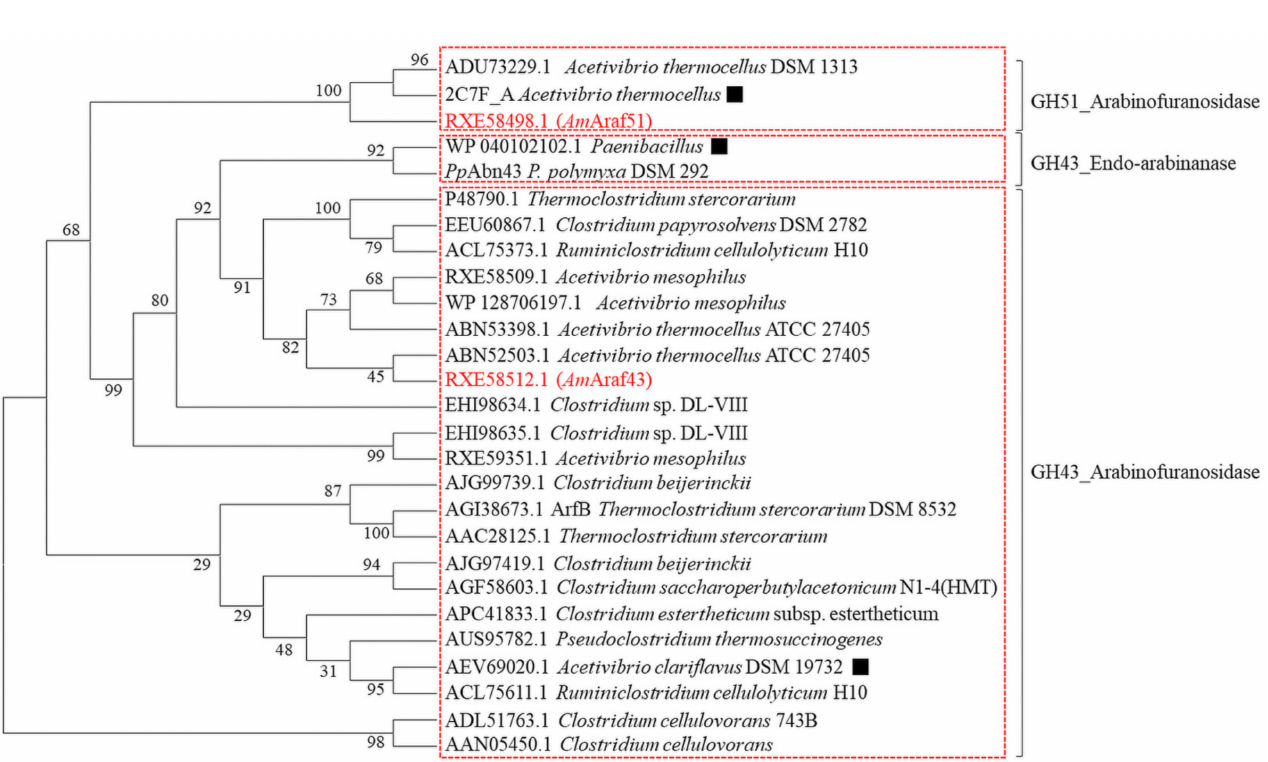
Figure 2. Phylogenetic tree of arabinosyl hydrolyases, including the exo- α - L -arabinofuranosidases ( Am Araf51 and Am Araf43) and the endoarabinanase Pp Abn43 used in this study, and two other putative GH43 enzymes (encoded by RXE59509.1 and RXE59351.1) from A. mesophilus strain N2K1. An alignment of NCBI amino acid sequences was performed using the MUSCLE algorithm. A neighbor-joining (NJ) tree was then constructed in MEGAX and tested with 500 replicate bootstraps. Bootstrap values are listed near each branch. The functionally of the characterized arabinosyl hydrolyases are indicated with a black square symbol ( (cid:4)